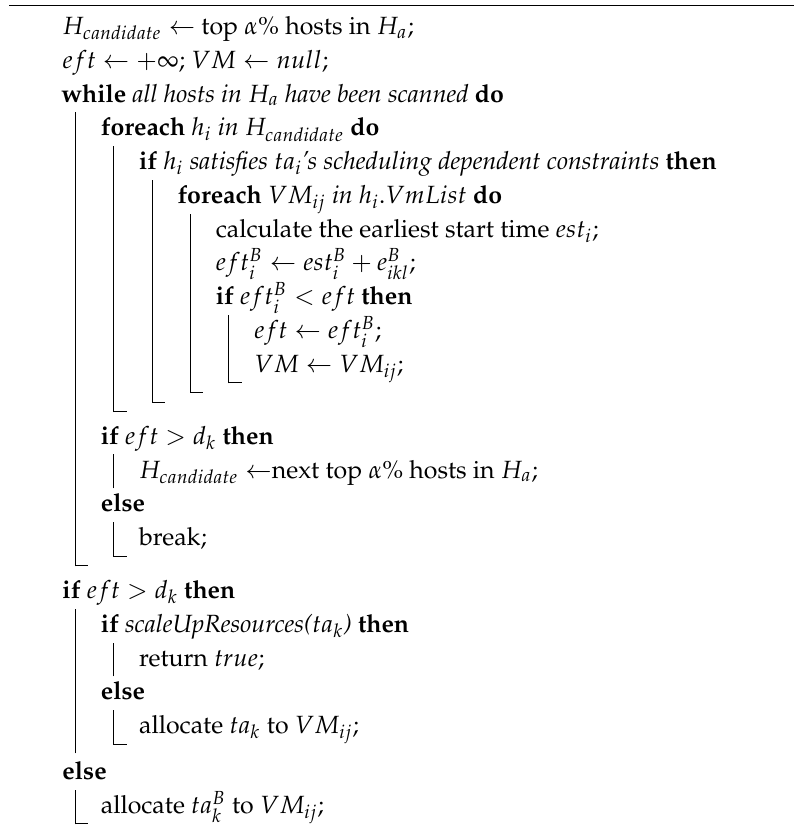
Algorithm 2: Pseudocode of primaries scheduling in